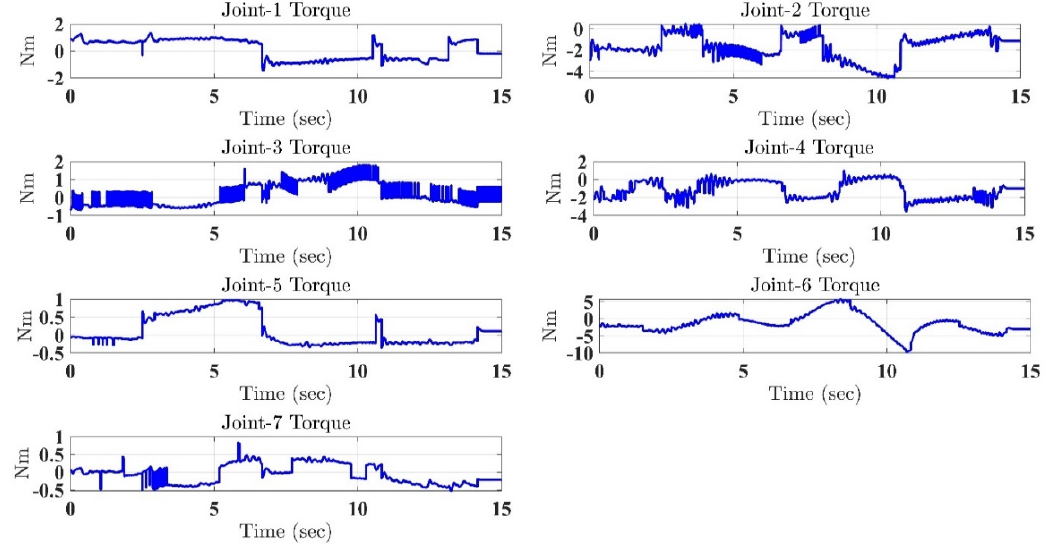
Figure 13. Control inputs under the conventional super-twisting controller.